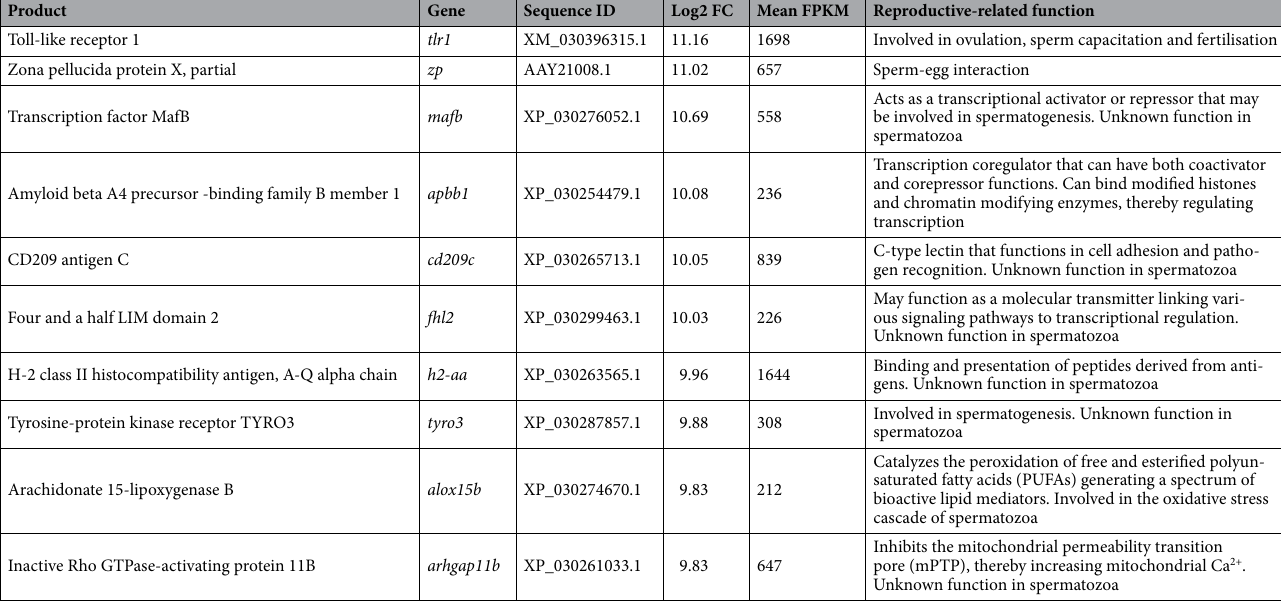
Table 1. Top 10 upregulated mRNAs in SPZ EJ , their fold-change in expression with respect to HGC and mean of fragments per kilo base of transcript per million mapped fragments (FPKM), and their potential associated functions according to GeneCards (www. genec ards.